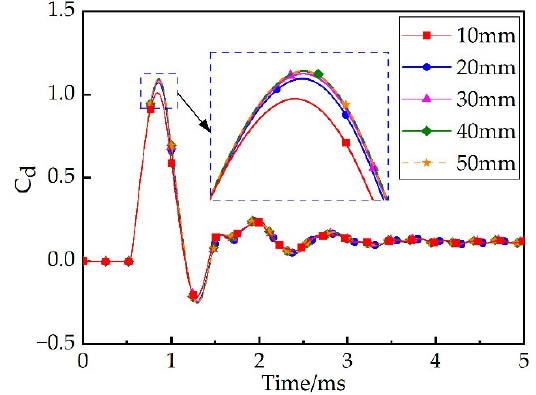
Figure 8. Acceleration coefficient of mesh with different size.